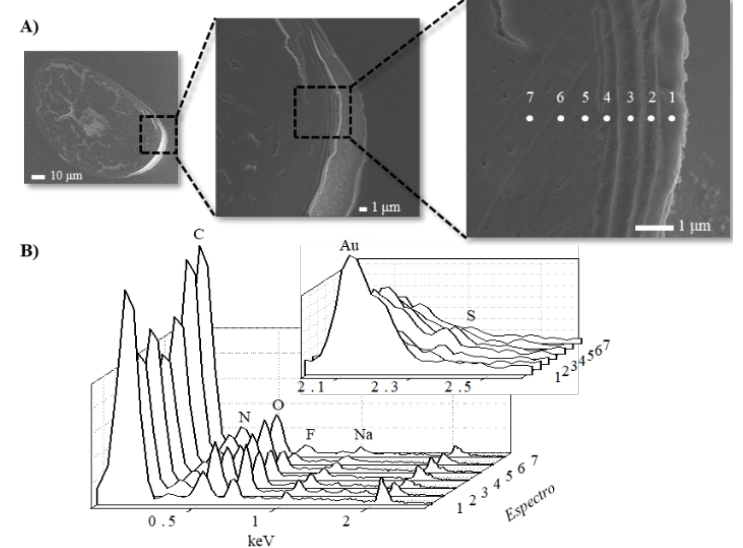
Figure 4. ( A ) Scanning electron microscopy images of a transversal cut of a hair fiber treated with a model conditioning formulation and two enlargements of the most external regions of the deposit. The numbers indicate the region in which electron dispersive spectroscopy analysis was performed. ( B ) Electron dispersive spectroscopy spectra for the di ff erent regions in panel a. Reprinted from [7], Copyright (2020), with permission from Elsevier.